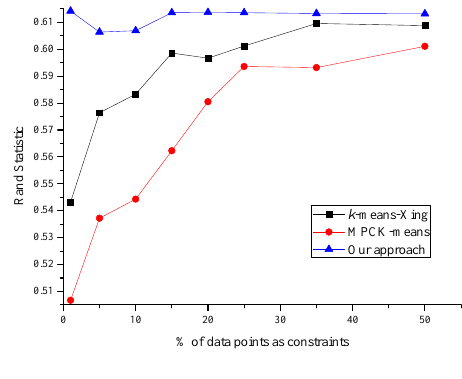
Fig.4 - Fig.7 show the effect of the size of pair-wise constraints on the quality of clustering on four UCI datasets (Diabet, Wdbc, Ionosphere and Protein). Most of these datasets are selected as “difficult-to- cluster” by Halkidi 19 .